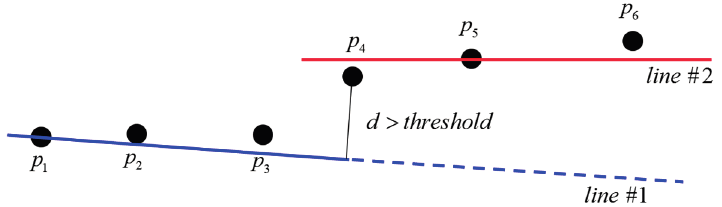
Figure 2. Incremental line extraction algorithm (adapted from